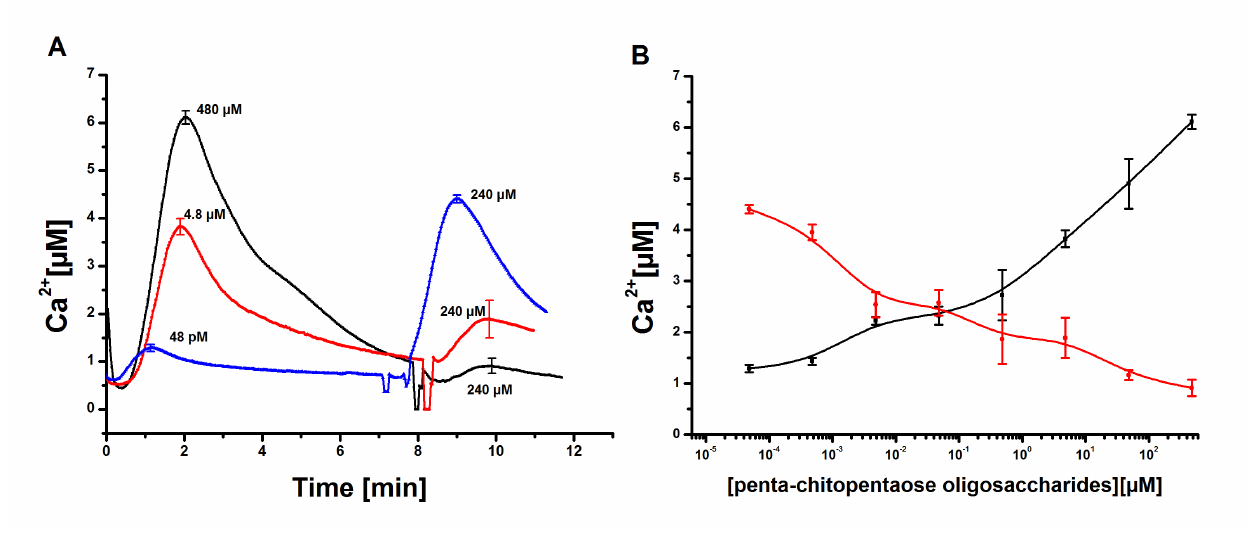
Figure 5. Measurement of cytosolic Ca 2+ concentrations in tobacco cell cultures upon elicitation with chitopentaose oligosaccharides at two time points. ( A ) Tobacco cell cultures were elicited with 480 µM, 4.8 µM and 48 pM of Ch5. Approximately 7 min later, a second elicitation with a Ch5 stimulus of 240 µM was carried out. The Ca 2+ transients induced by the first and second elicitation were recorded. Error bars indicate standard deviation. ( B ) Dose-response diagram of the first and second response of Ch5 treated Ca 2+ signals, shown exemplarily in ( A ). The Ch5 concentration of the first elicitation was reduced (black curve), while the second Ch5 elicitation was constantly held at 240 µM (red curve). Ca 2+ answers are always set in relation to the stimulus level of the first stimulation. Error bars indicate standard